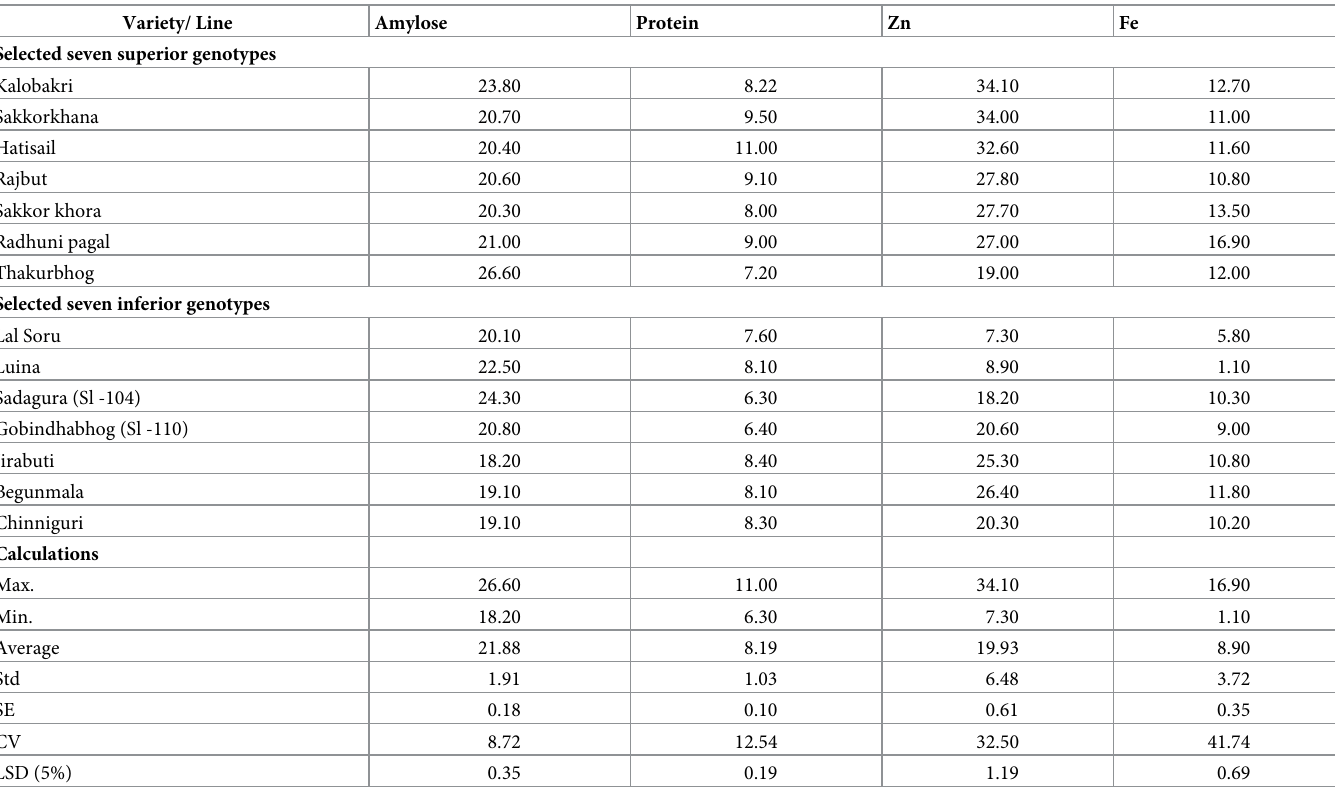
Table 1. Mean values of selected superior and inferior lines for studied traits. Variety/